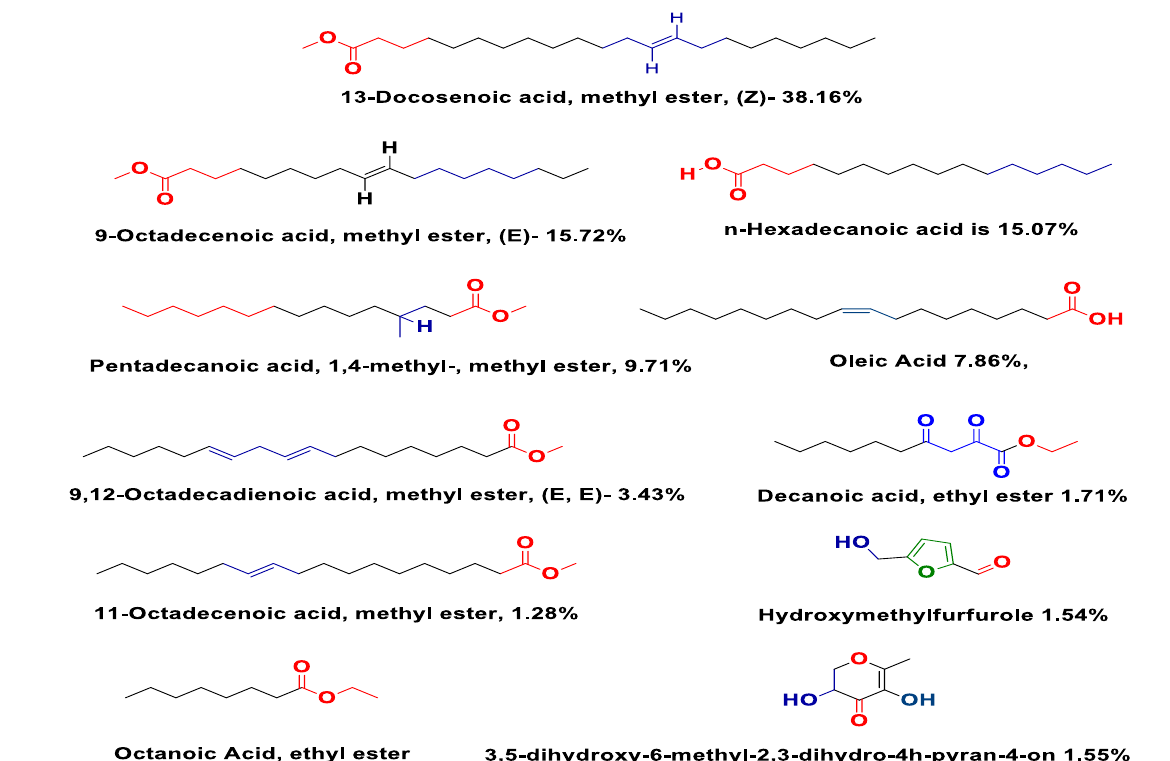
Figure 2. Chemical structure of chemical constituents showing higher concentration. Table 1. Chemical constituents found in the methanol extract of Carduus edelbergii . Sr.